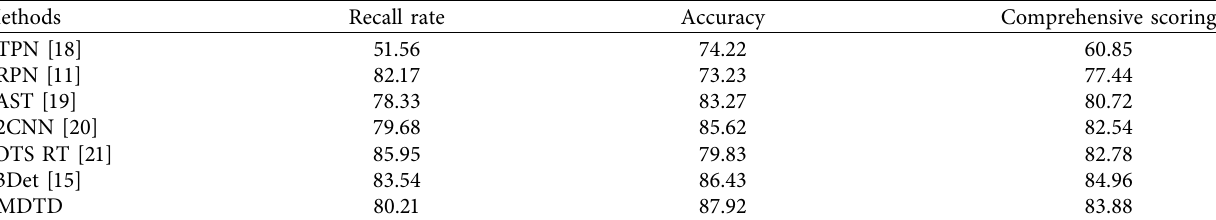
Table 4: ICDAR2015 comparison results (%).